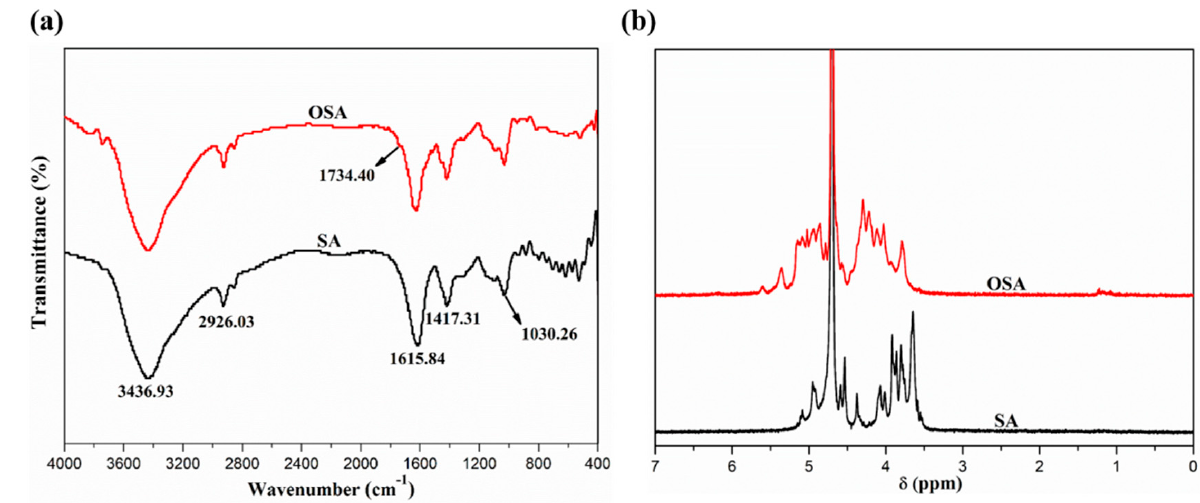
Figure 4. ( a ) FT-IR spectra and ( b ) 1 H NMR spectra of SA and OSA.